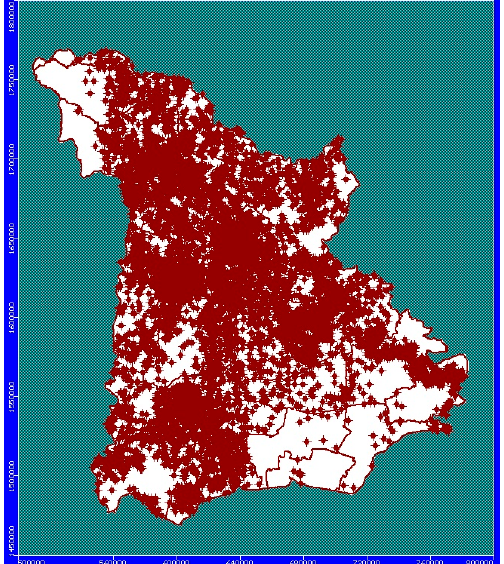
Figure 8. Distribution of pumping wells in the model.